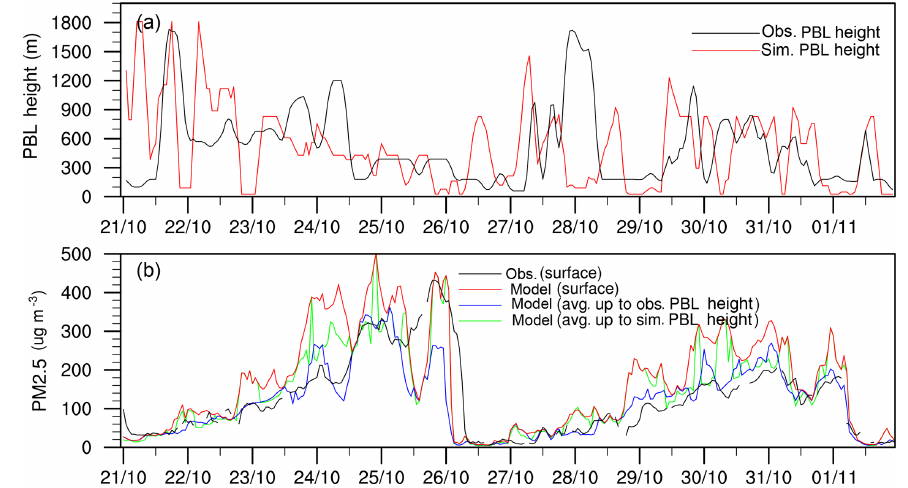
Figure 6. Simulated and observed boundary layer mixing height in metres (a) and simulated and observed PM 2 . 5 (in µgm − 3 ) showing the effect of mixing up to the PBL height in the model (b) between 21 October and 1 November 2014.